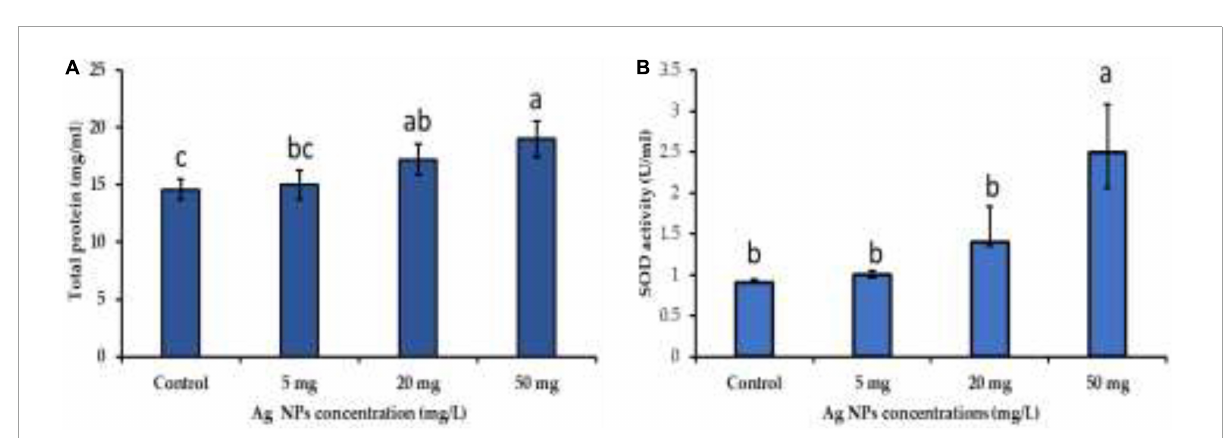
FIGURE6 The impact of different doses of biogenic AgNPs on (A) total protein content and (B) SOD activity. a , b , c Means within the same column with different superscripts differ significantly ( P <